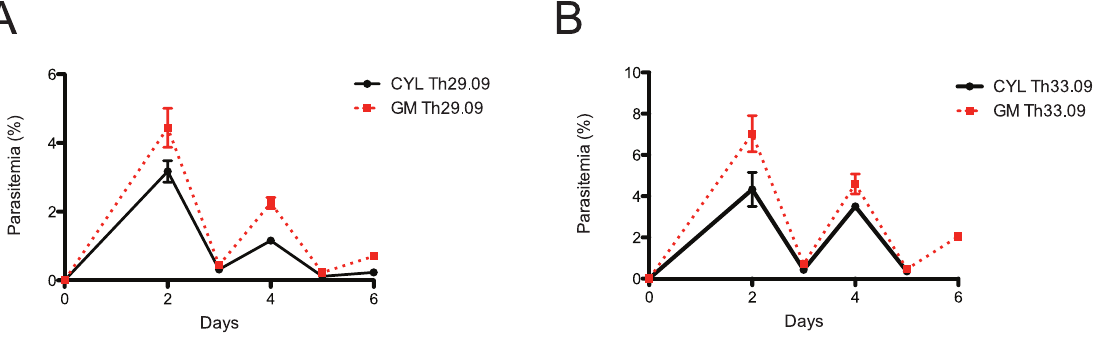
Figure 5. Cryopreserved field isolate recovery time. Time to positive growth from field prepared cryopreserved parasites without previous culture adaptation: A. isolate Th29.09. B. isolate Th33.09. Results from individual experiments are shown, conducted in triplicate, with error bars representing standard error.